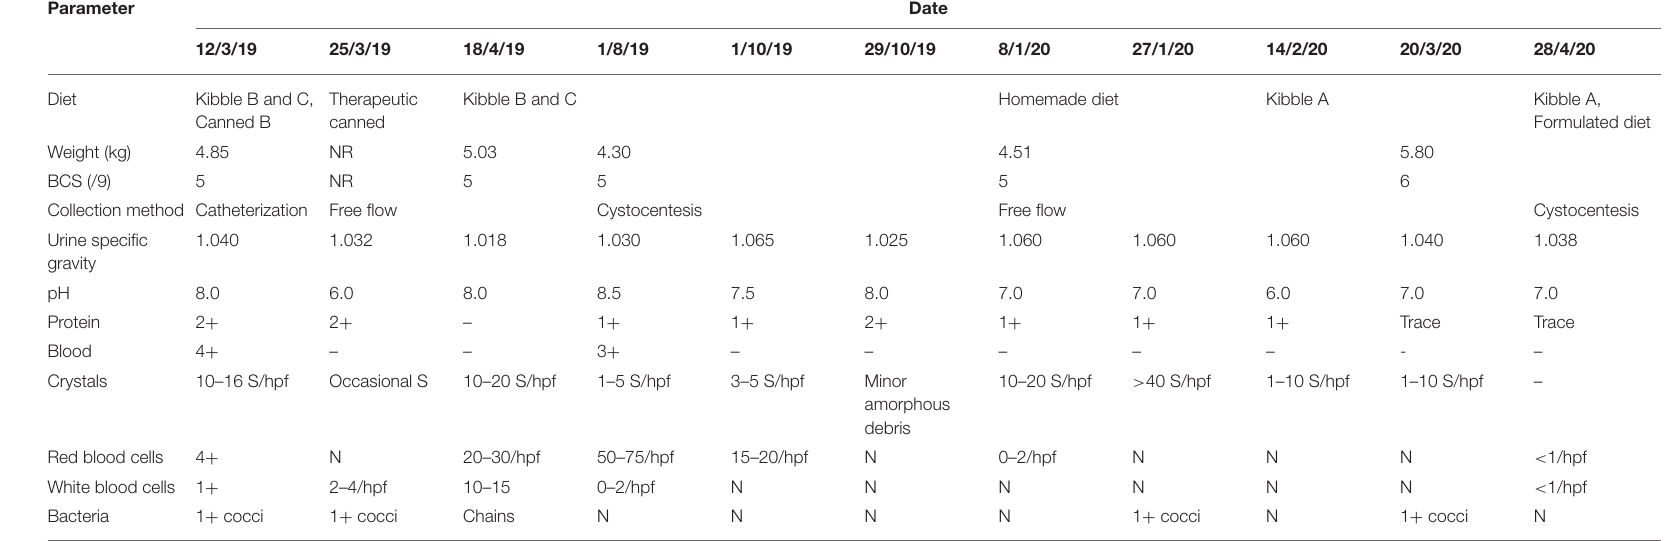
TABLE 2 | Selected urinalysis characteristics from time of urethral obstruction to end of follow-up.